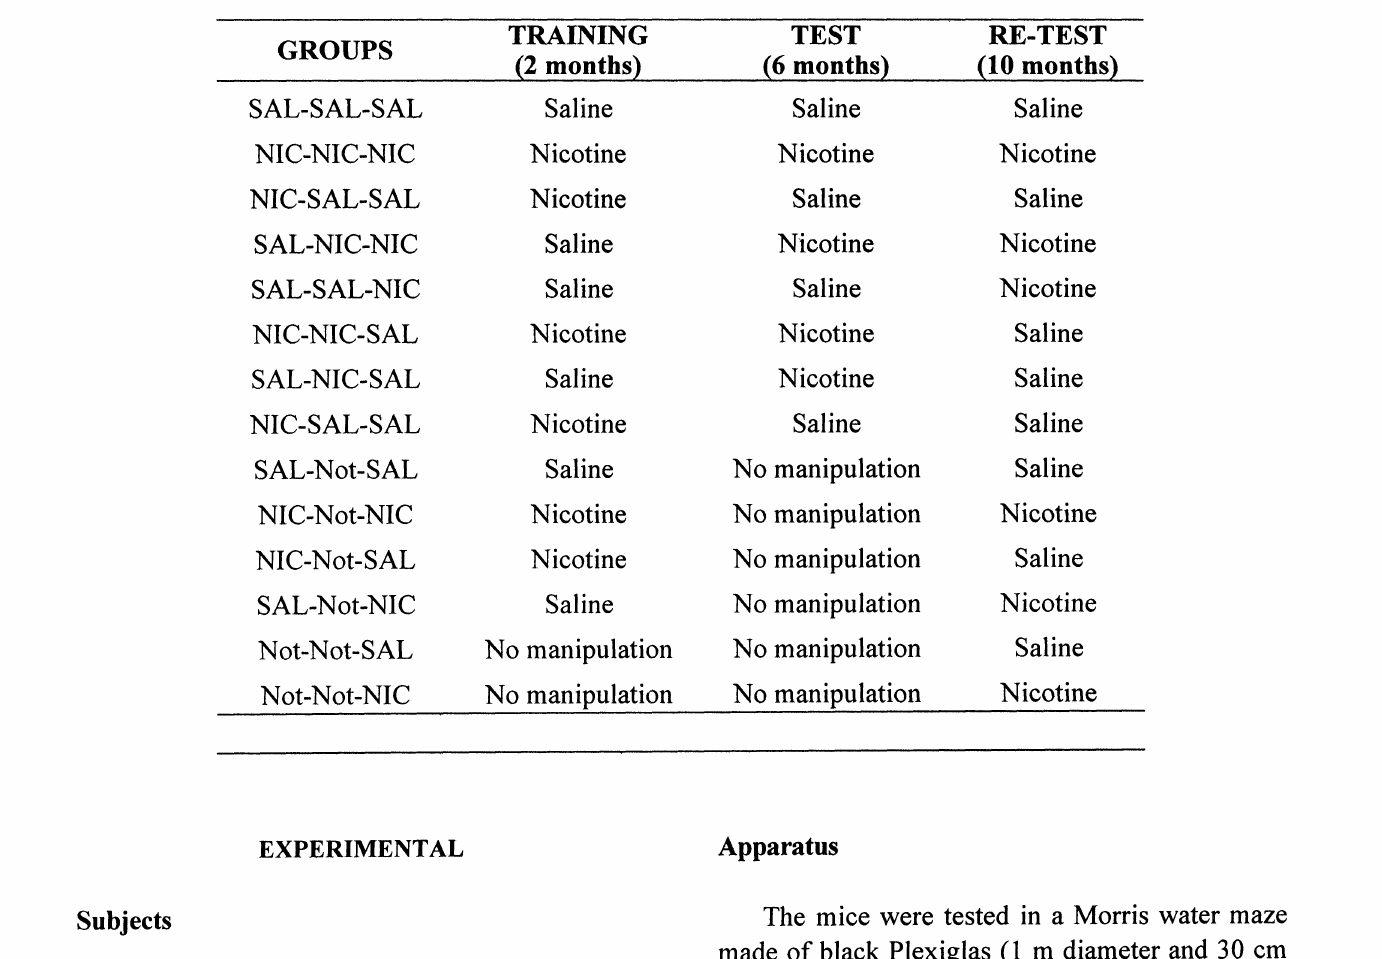
Experimental design of the longitudinal study showing the treatment schedule in each experimental